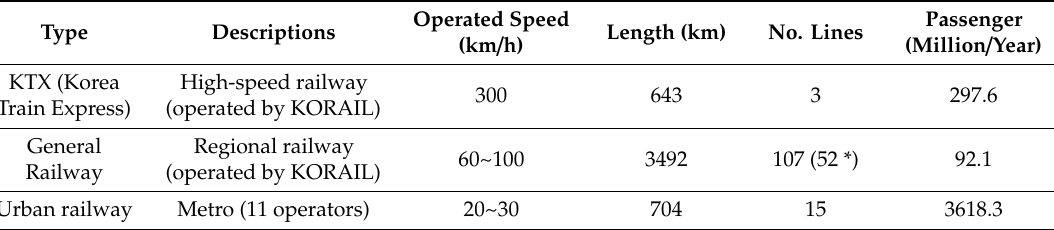
Table 1. Description of railway statistics in Korea (2018).